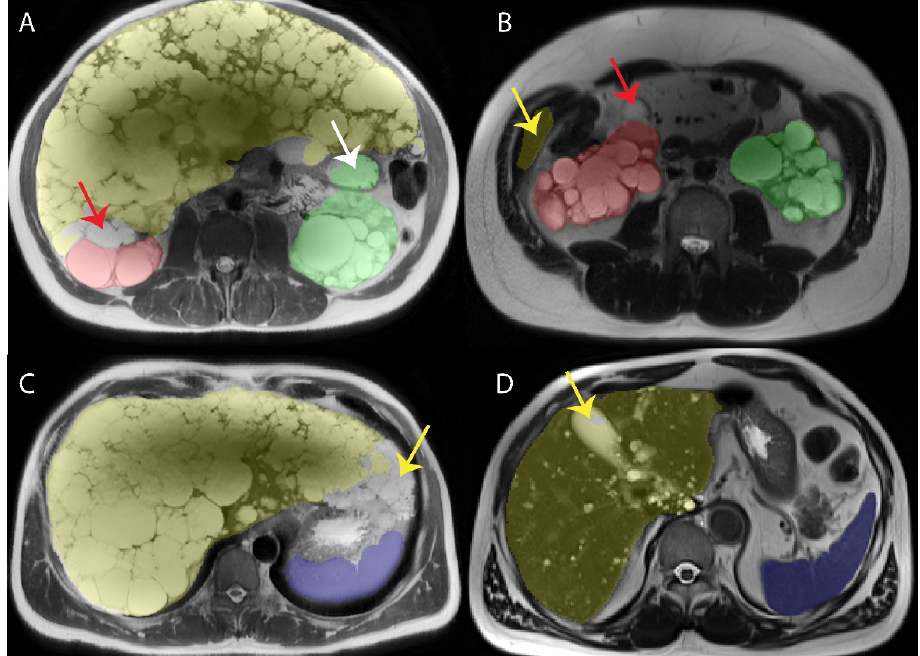
Figure 5. Bland-Altman plots of prospective validation comparing the inference volume with radi- ologist corrected volume for ( A ) left kidney, ( B ) right kidney, ( C ) spleen and ( D ) liver.